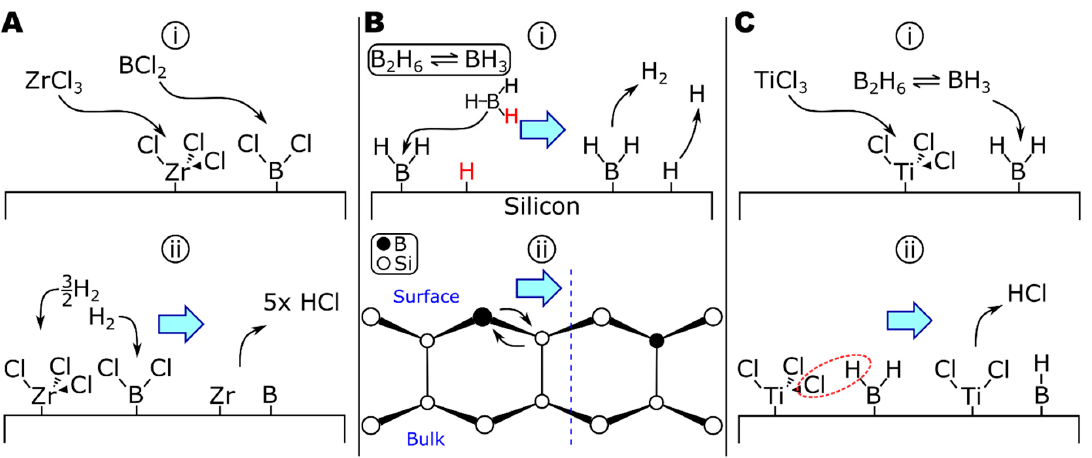
Figure 4. The deposition of boron in ( A ) ZrCl 4 -BCl 3 -H 2 , ( B ) B 2 H 6 , and ( C ) TiCl 4 -B 2 H 6 -H 2